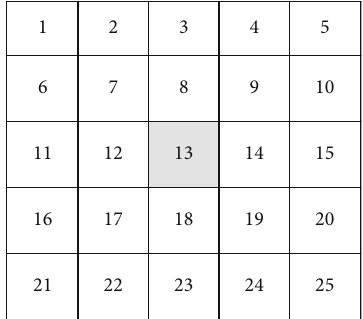
Figure 5: Schematic diagram of sampling points of saturation fi eld